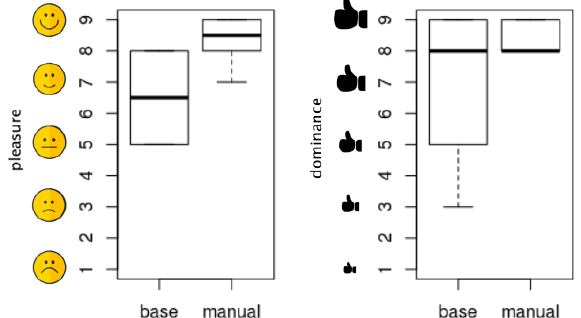
Fig. 5. Boxplots of pleasure and dominance indexes - slideshow.